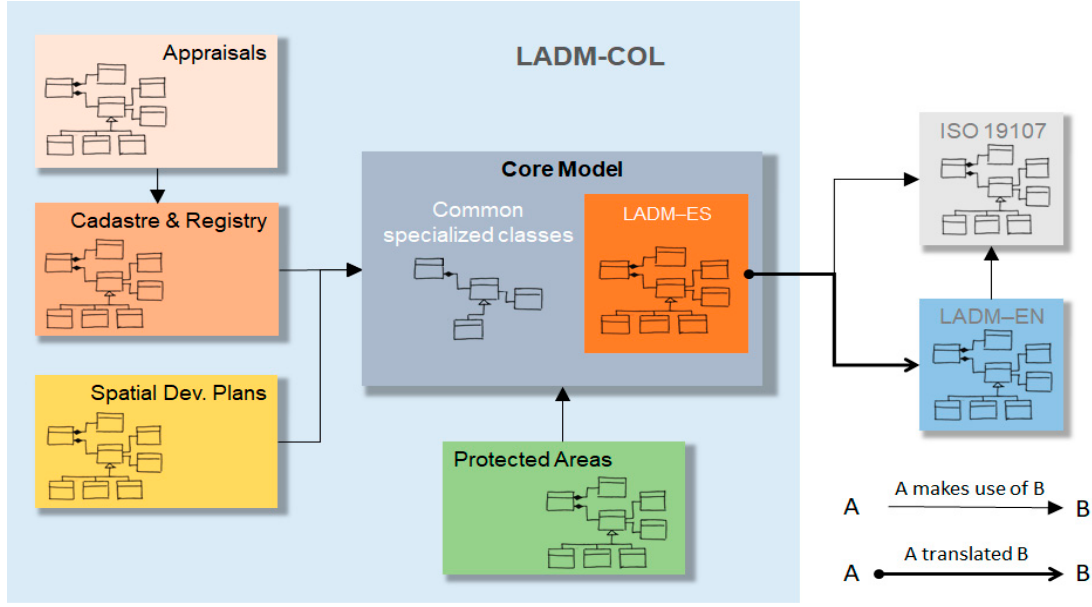
Figure 8. Modularity of COL_LADM model.